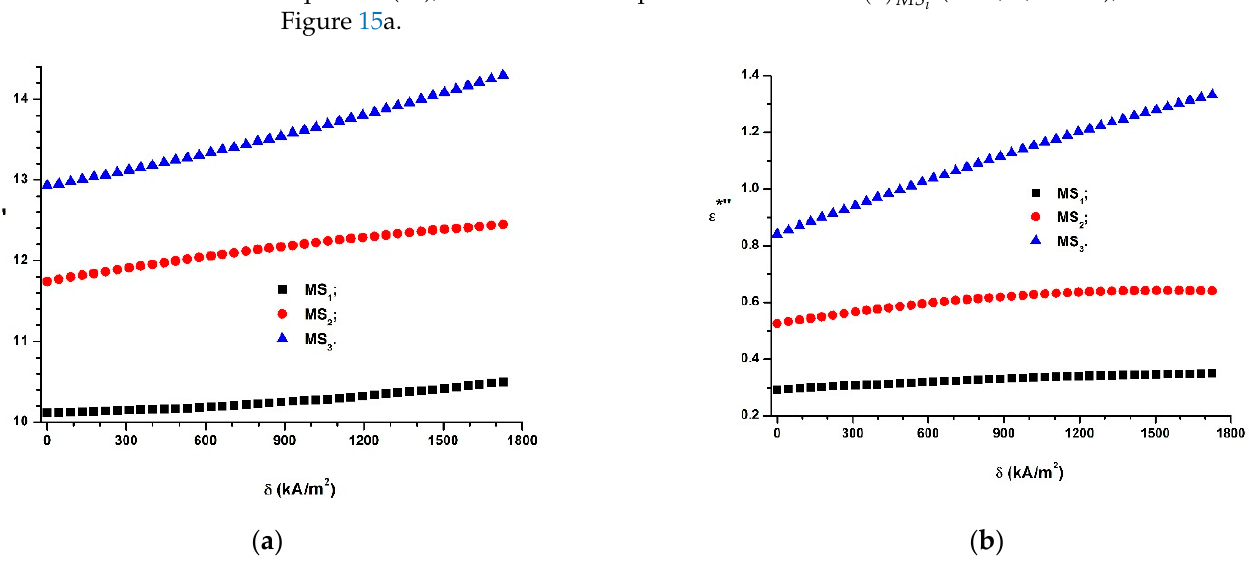
Figure 15. ( a ) Apparent relative dielectric permittivity, ε ∗(cid:48) , as a function of the magnetic field intensity gradient, δ ; ( b ) apparent dielectric loss coefficient, ε ∗ (cid:48)(cid:48) , as a function of the magnetic field intensity gradient, δ